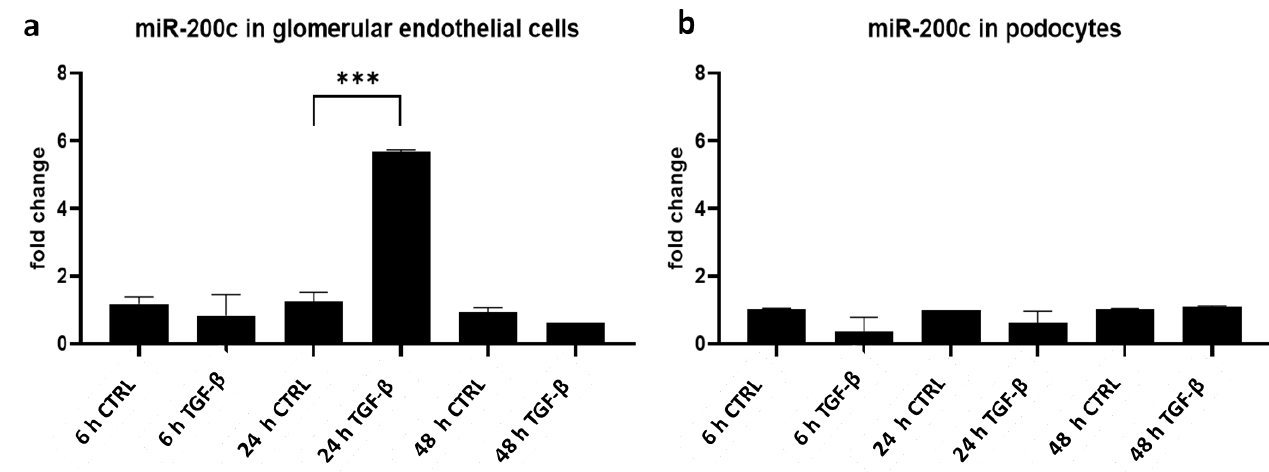
Figure 3. TGF- β stimulation induces miR-200c expression in cultured glomerular endothelial cells. ( a , b ) qPCR for miR-200c detection in cultured human glomerular endothelial cells ( a ) and human podocytes ( b ) normalized to U6 RNA. Data are given as fold change compared to unstimulated cells (CTRL) at the respective time point. Cells were stimulated with TGF- β for 6 h, 24 h and 48 h, *** p < 0.001. Reproducible data from three independent experiments.